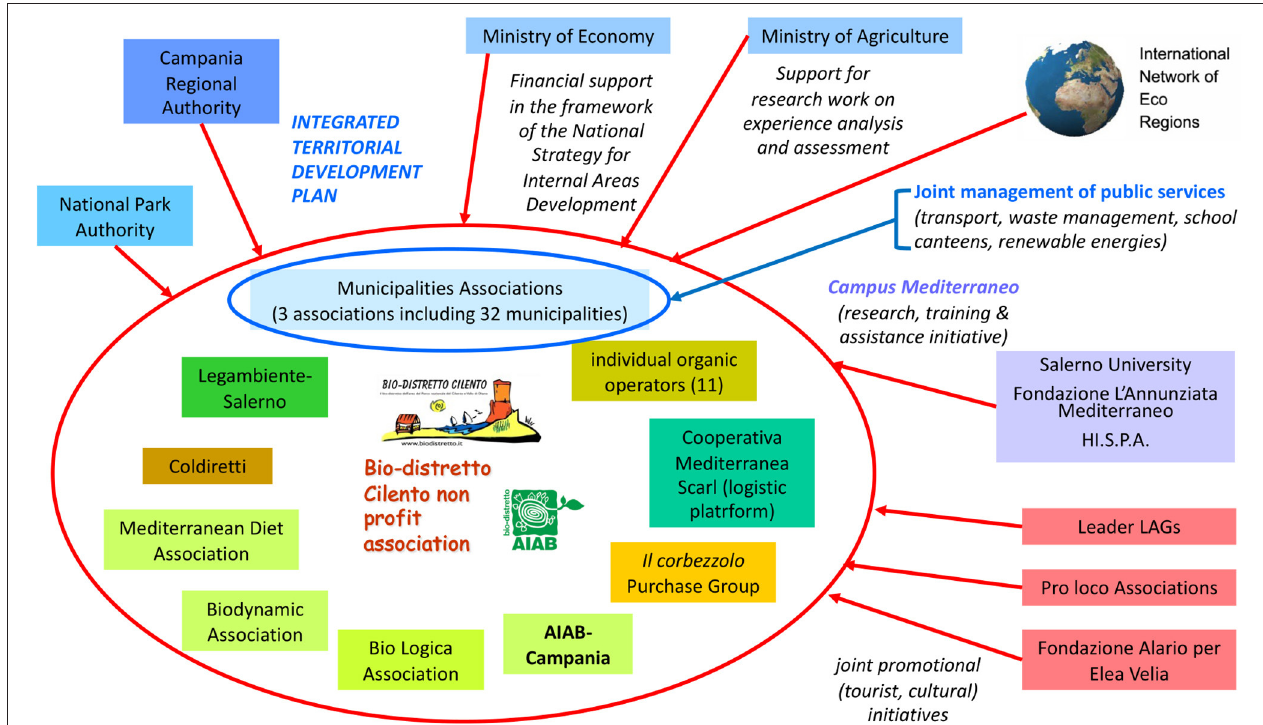
FIGURE 3 | Cilento Eco-Region stakeholders map. Adapted from Pugliese et al. (2013) with permission from CIHEAM Bari.